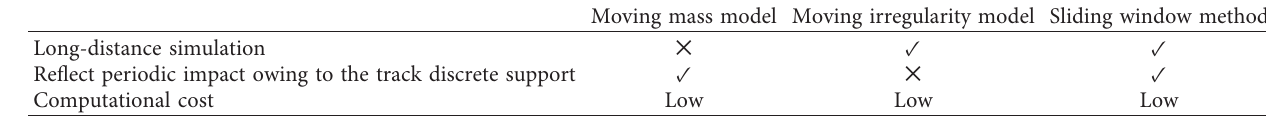
Figure 7: Comparison of wheel/rail normal forces between the proposed model and the moving irregularity model: (a) time domain; (b) frequency Table 1: Comparison of three models.